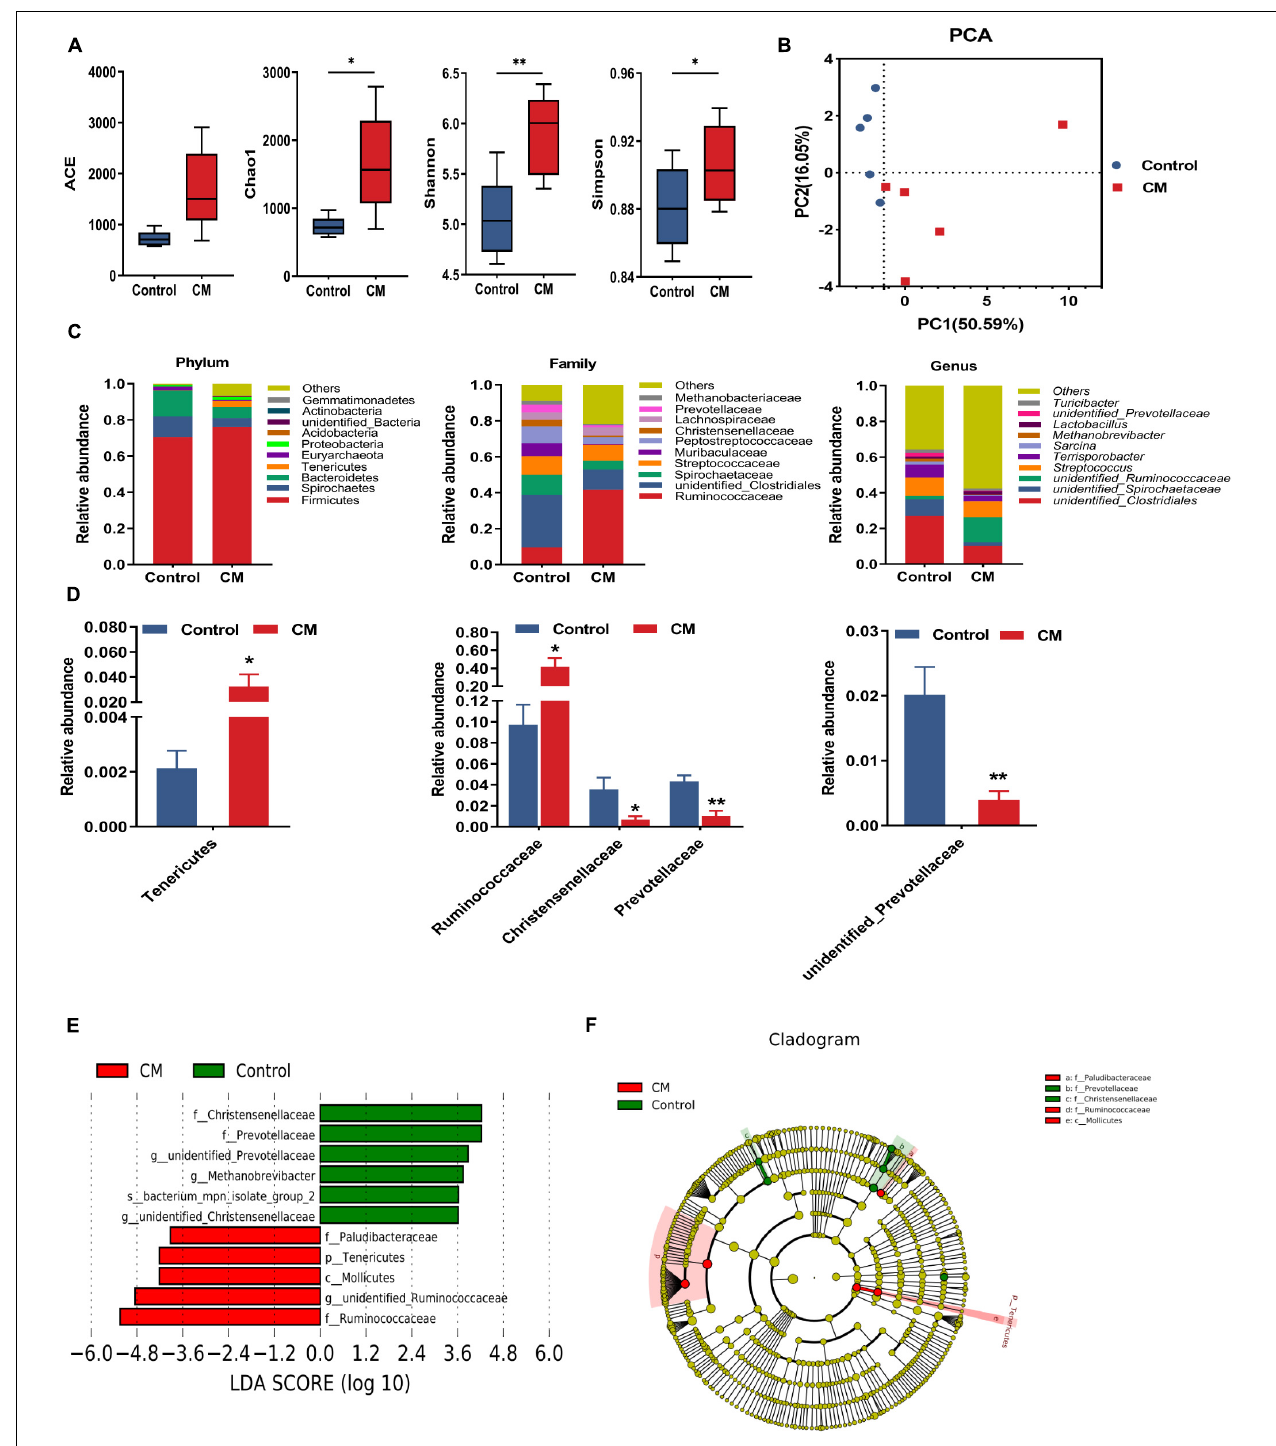
FIGURE 5 | CM changes the composition of the colonic microbiota. (A) Alpha diversity indexes (Ace, Chao1, Shannon, and Simpson) of colonic microbiota. (B) The principal component analysis (PCA) of colonic microbiota. (C) Microbiota compositions at the phylum level, family level, and genus level. (D) Statistical analysis of the differences in microbiota at the phylum level, family level, and genus level. (E) LDA score. Enriched taxa with an LDA score > 3.6 are shown in the histogram, control group-enriched taxa are indicated with a positive LDA score (green), and the taxa enriched by the CM group have a negative score (red). (F) LEfSe taxonomic cladogram. Taxa enriched in the CM group are shown in red, and taxa enriched in the Control group are shown in green. Control, pigs fed a basal diet; CM, pigs fed the basal diet supplemented with CM at 300 mg/kg. Data are presented as the mean ± SEM ( n = 5). * P < 0.05, ** P < 0.01.